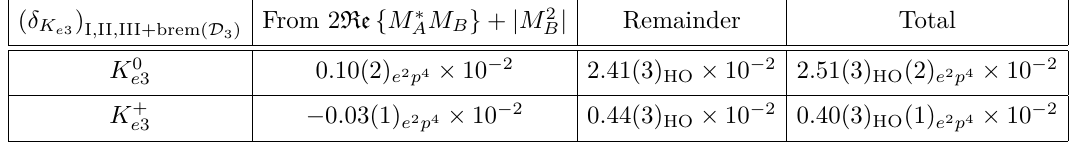
Table 4 . Sum of the IR-divergent one-loop contribution I, II, III and the bremsstrahlung contri- bution in the D 3